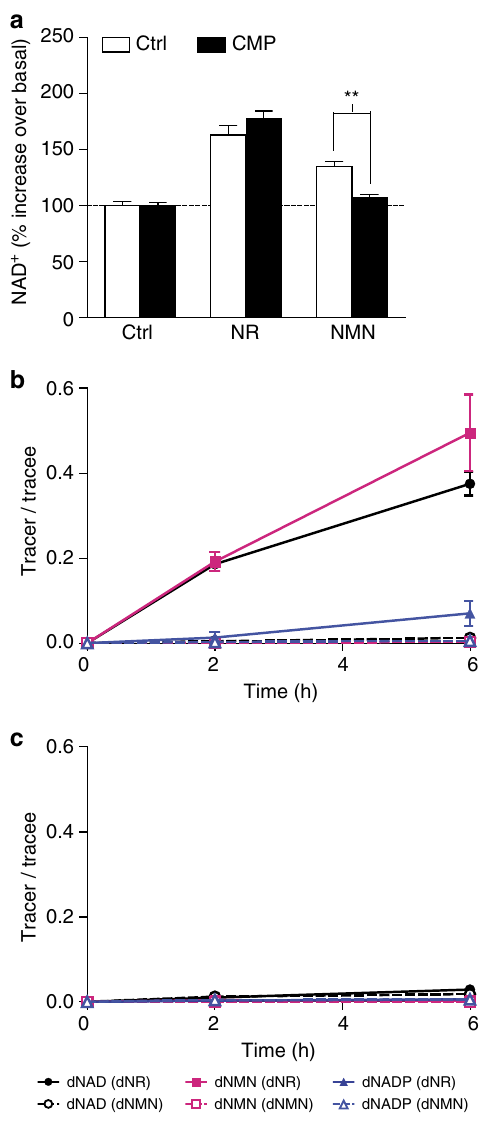
Figure 6 | Extracellular conversion of NMN to NR by hepatocytes. ( a ) Primary hepatocytes were isolated from 10 to 15 weeks old WTmice. Cells were treated with 2 m M FK866 and ± 2mM CMP for 1h. Then, 0.5mM NR or NMN was added and NAD þ was measured after 2h. ( b , c ) WT ( b ) and NRK1KO ( c ) hepatocytes were treated with [ 2 H]-[ 13 C]-double labelled NR or NMN. Intracellular enrichment of labelled compounds. Results shown are mean ± s.e.m., ** P o 0.01 versus ctrl by two-sided unpaired T -test ( n ¼